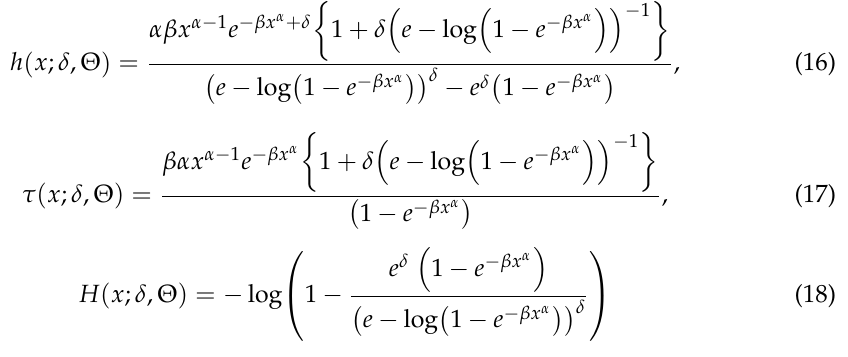
and (iv) left-skewed (in blue).